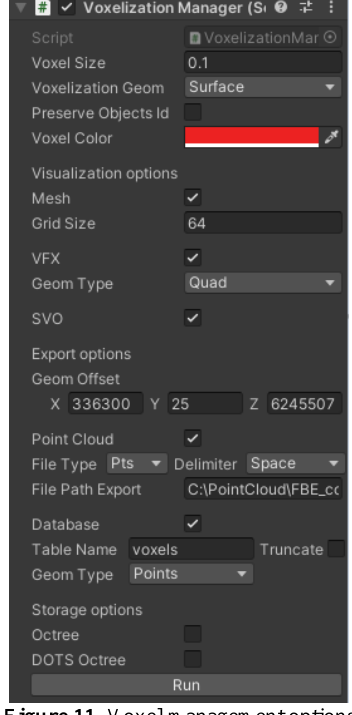
Figure 11 . Voxel management